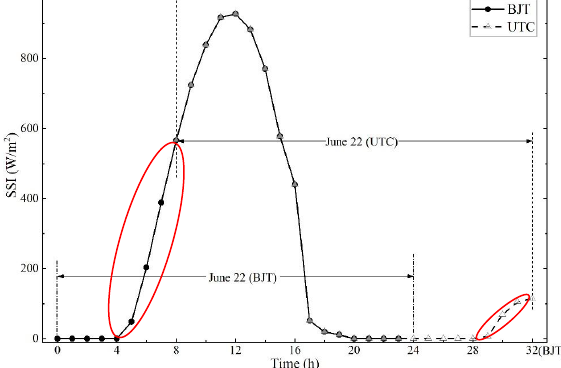
Figure 3 . Hourly SSI variation in China (longitude: 117.03°E, latitude: 39.05°N) under UTC and BJT on June 22,